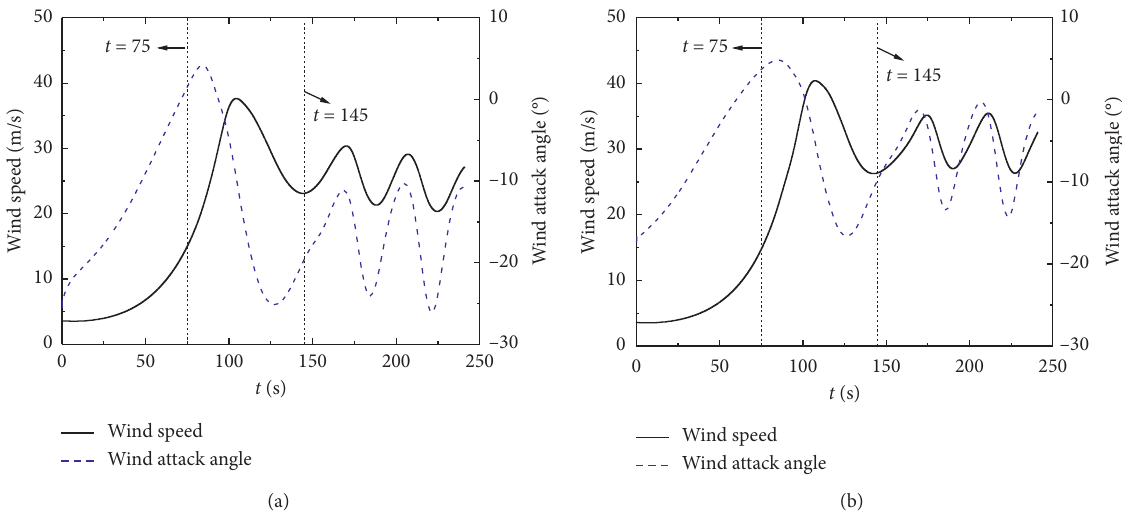
Figure 16: Synchronous comparisons of time-history curves of wind speed and wind attack angle in the gorge terrain. (a) The midspan point. (b) The 1/4 span